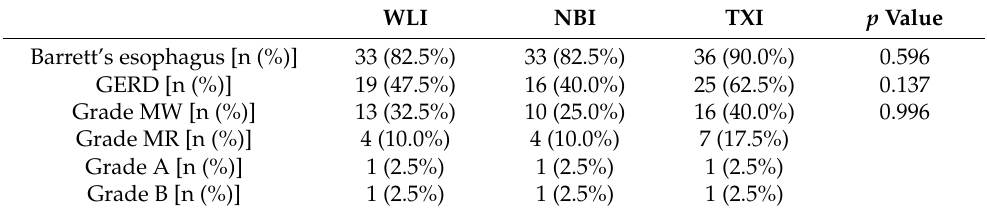
Table 2. Endoscopic Barrett’s esophagus and esophagitis among WLI, NBI, and TXI.